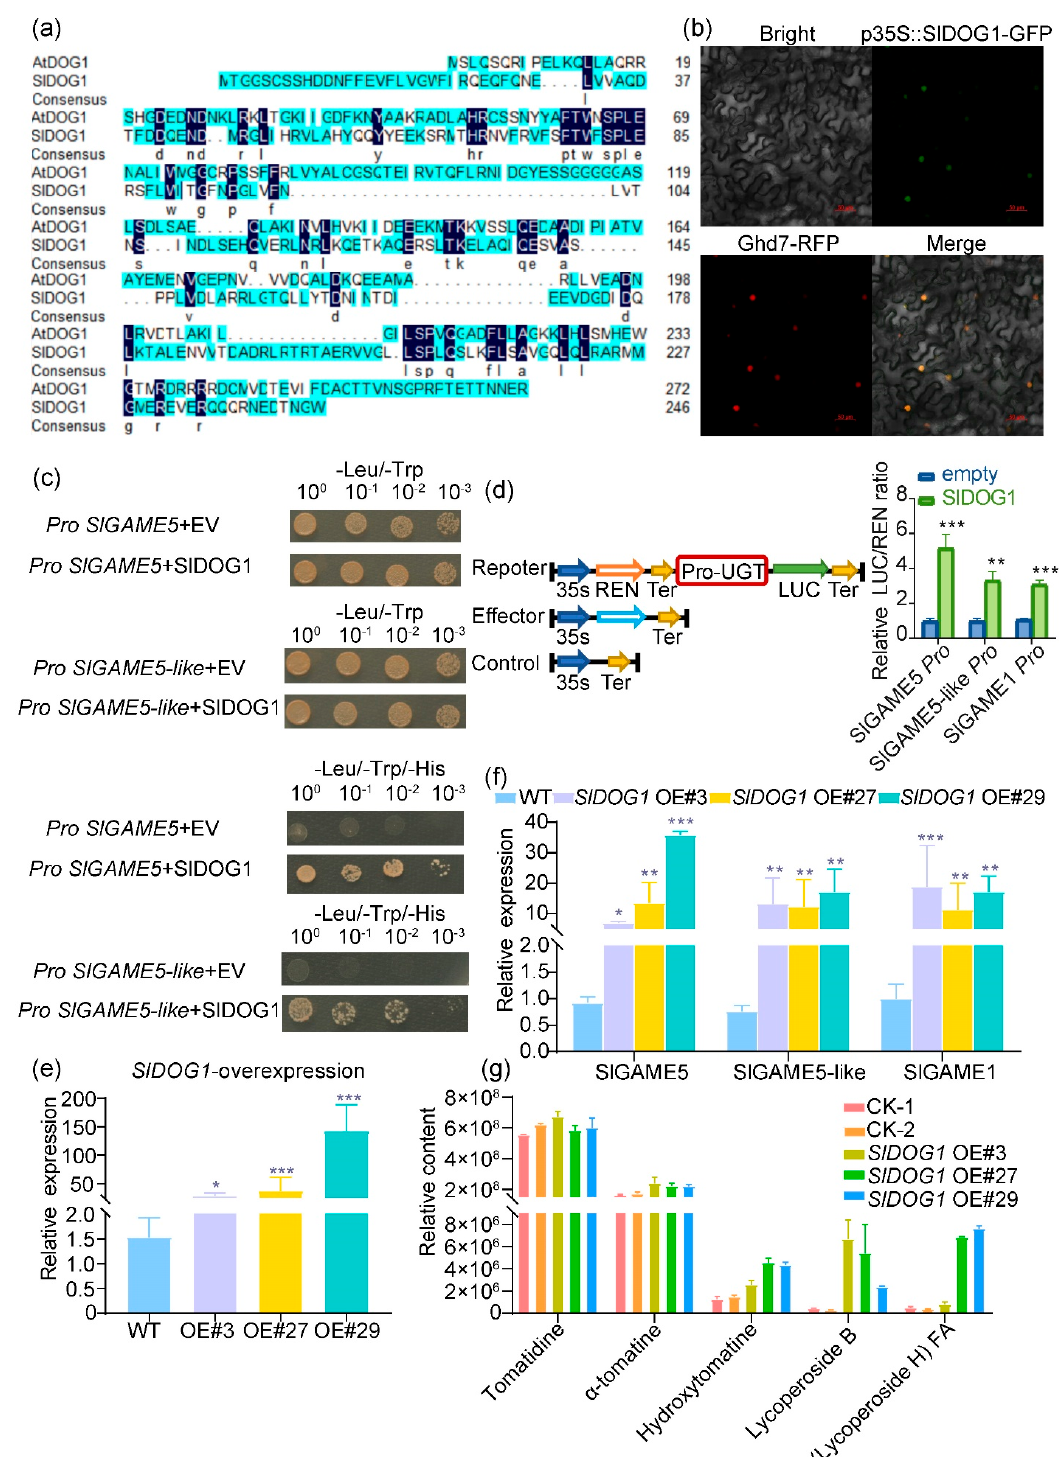
Figure 4. SlDOG1 interacts with SlGAME in vivo and in vitro. ( a ) Multiple sequence alignment of SlDOG1 and its homologs. ( b ) Nuclear localization of GFP-SlDOG1 fusion proteins in the leaf epidermal cells of Nicotiana benthamiana . Bar = 50 µm. ( c ) A yeast one-hybrid assay showing interactions between SlDOG1 and SlGAME5 , SlGAME5-like . ( d ) Dual luciferase reporter assay showing how SlDOG1 can induce the activity of a common promoter of SlGAME1-like genes. ( e ) SlDOG1 expression levels in three independent transgenic lines as determined by real-time PCR analysis. ( f ) The expression levels of SlGAME5 , SlGAME5-like , and SlGAME1 in